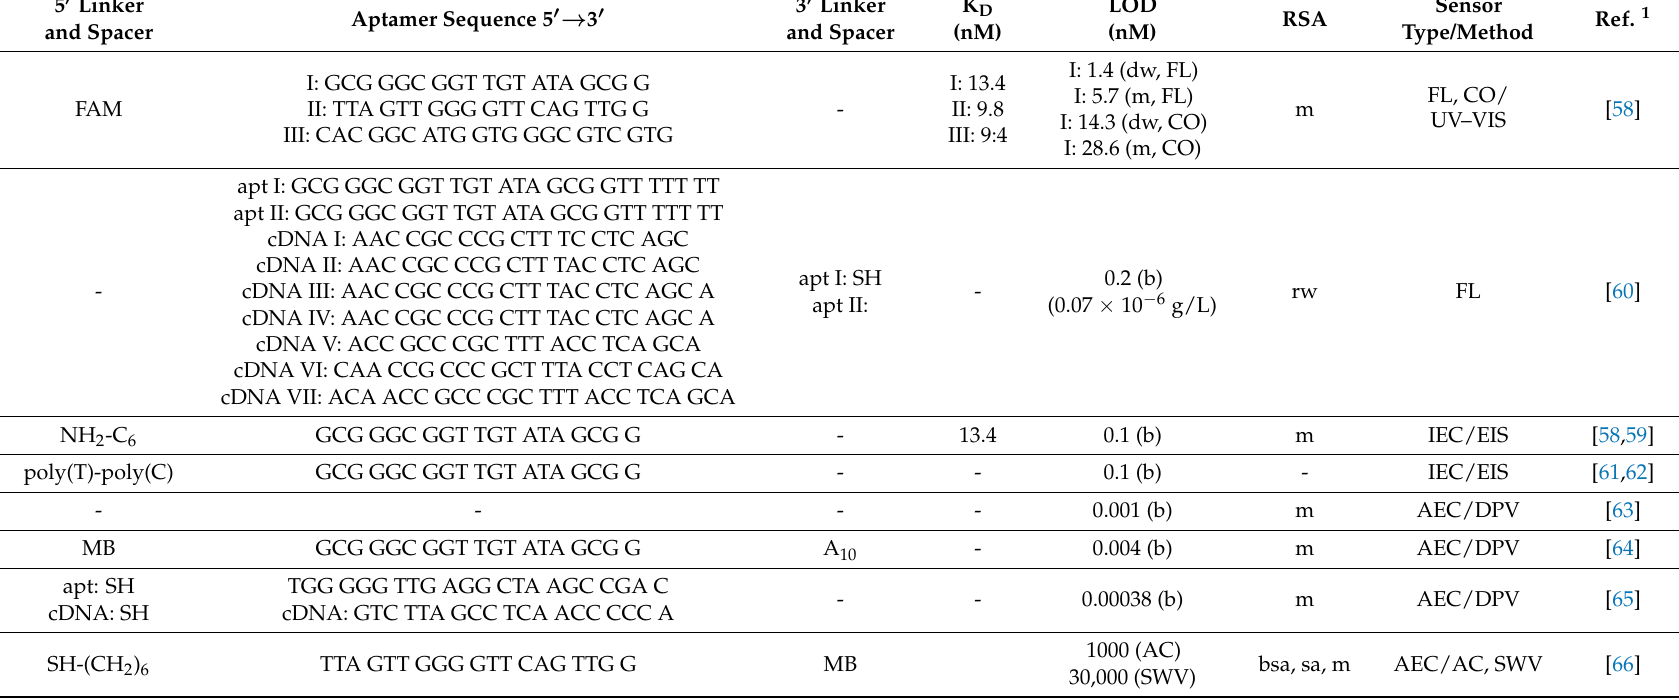
Table 1. Aptamer sequence, dissociation constant (K D ), limit of detection (LOD), real sample analysis (RSA), and realized sensor type and measuring method for ampicillin, mentioned in the corresponding references (Ref). AC = alternating current, AEC = amperometric electrochemical, apt = aptamer, bsa = bovine serum albumin, cDNA = complementary DNA, CO = colorimetric, CV = cyclic voltammetry, DPV = differential pulse voltammetry, EBFC = enzyme biofuel